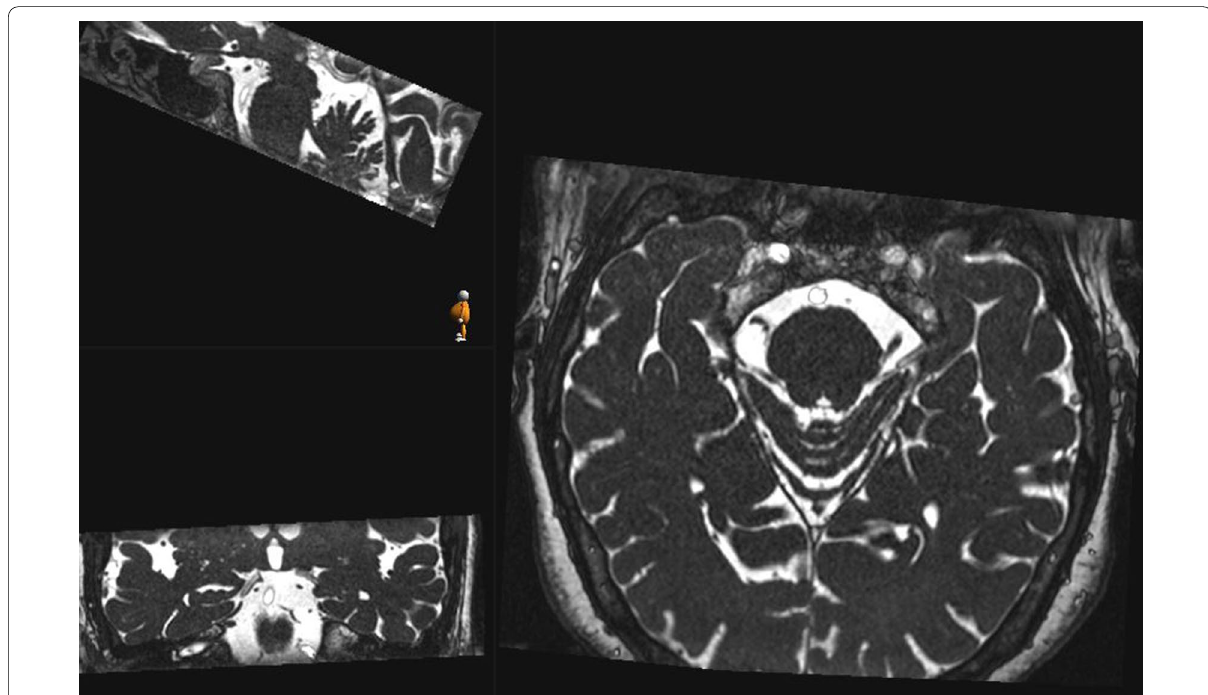
Fig. 1 Preoperative axial MRI with constructive interference in steady state showing an offending vascular loop near the right trigeminal nerve complex with reconstruction in the sagittal/coronal